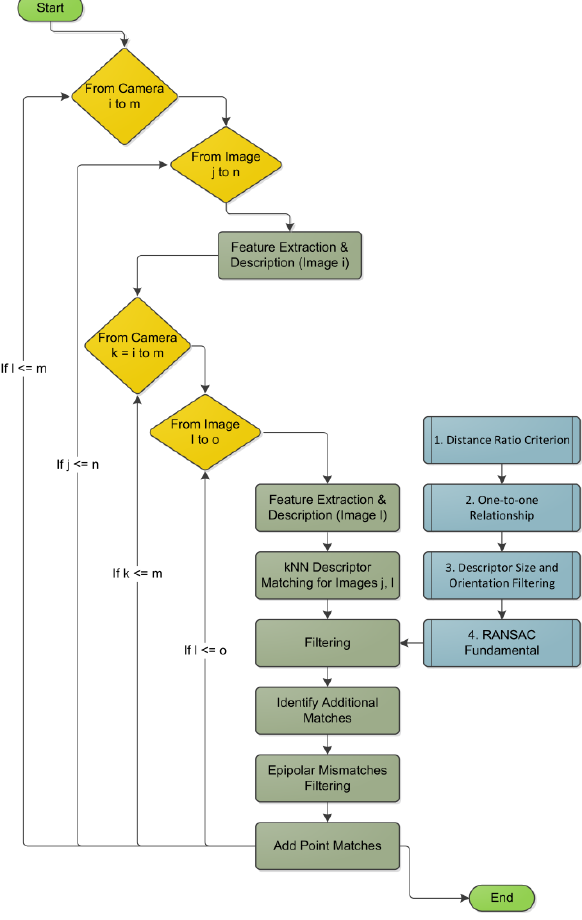
Figure 1. Flowchart of the proposed